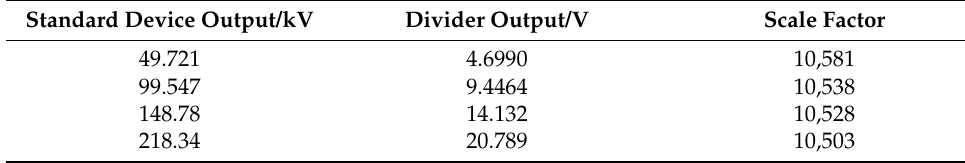
Table 3. AC test results at room temperature.